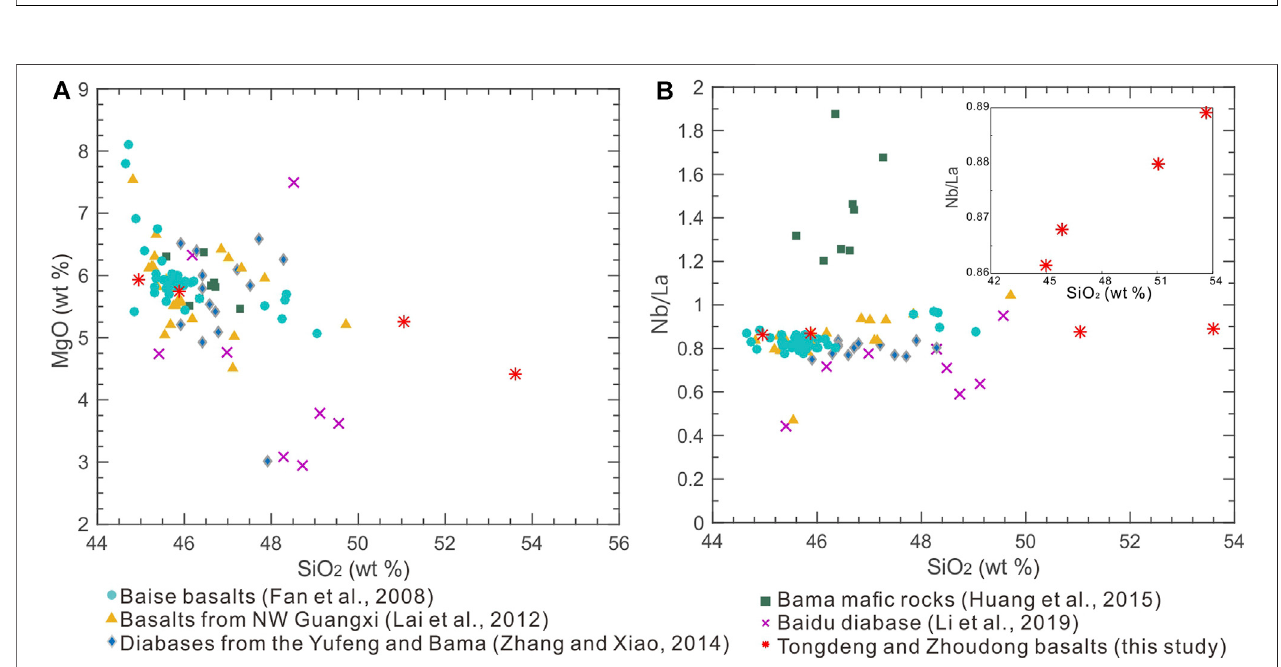
FIGURE 9 | (A) SiO 2 -MgO and (B) Nb/La-SiO 2 diagrams for the Longlin basalt samples.